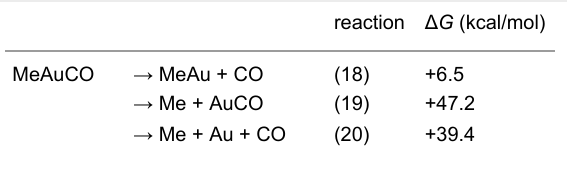
Table 3: Calculated reaction energies for